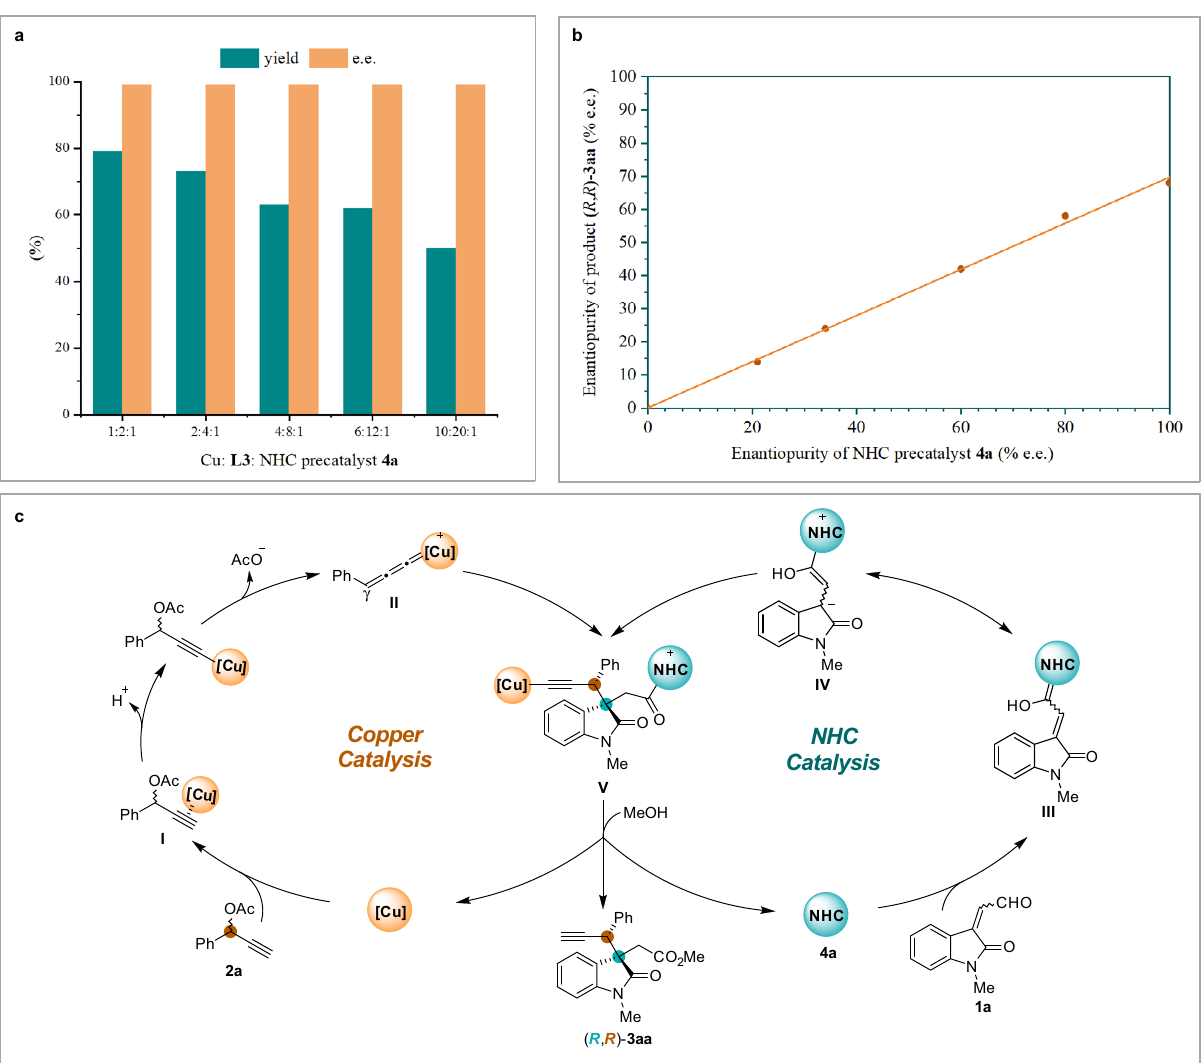
Fig. 6 Mechanistic investigation and proposed catalytic cycles. a Reaction outcomes with different catalyst loadings. b Nonlinear experiments. c Proposed catalytic